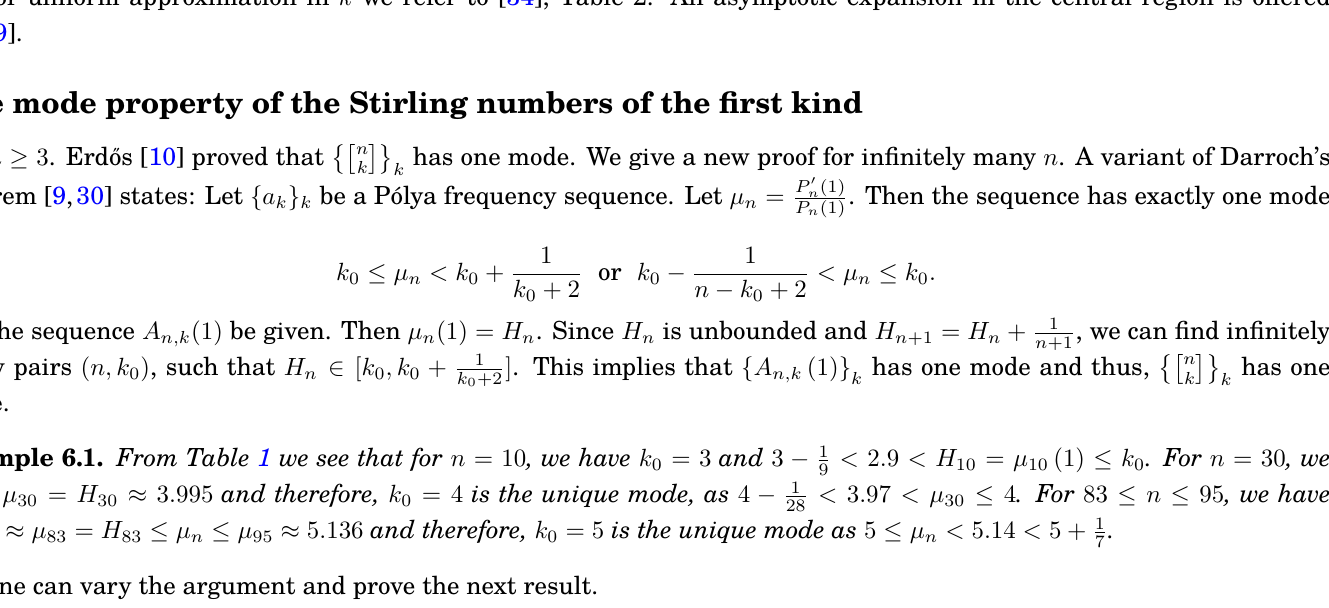
(cid:2) 100 (cid:3) / 99! (Table 5